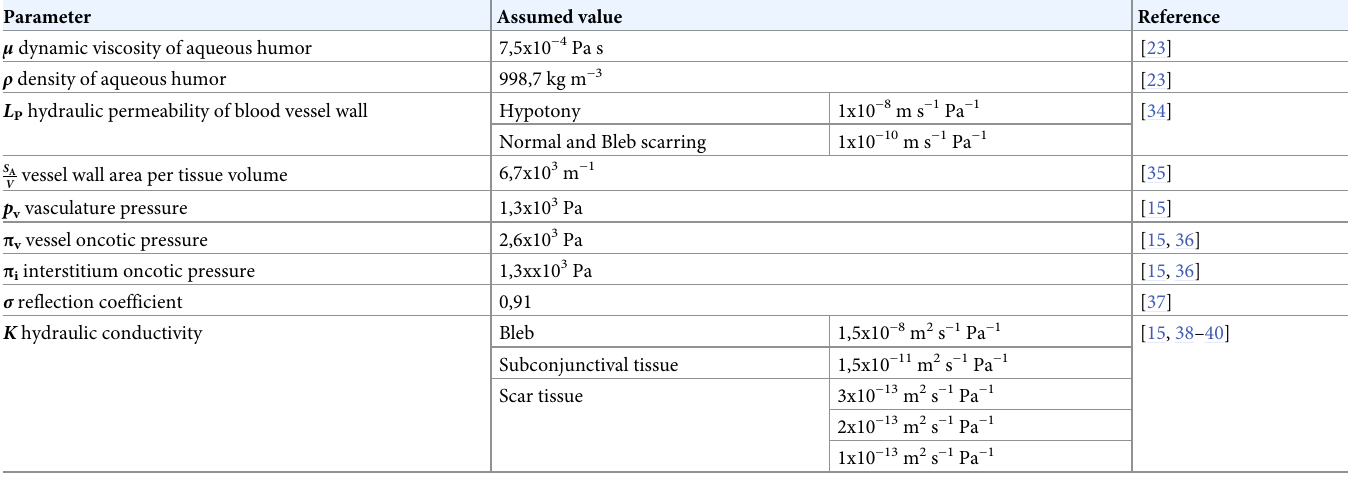
Table 1. Parameter values used in the